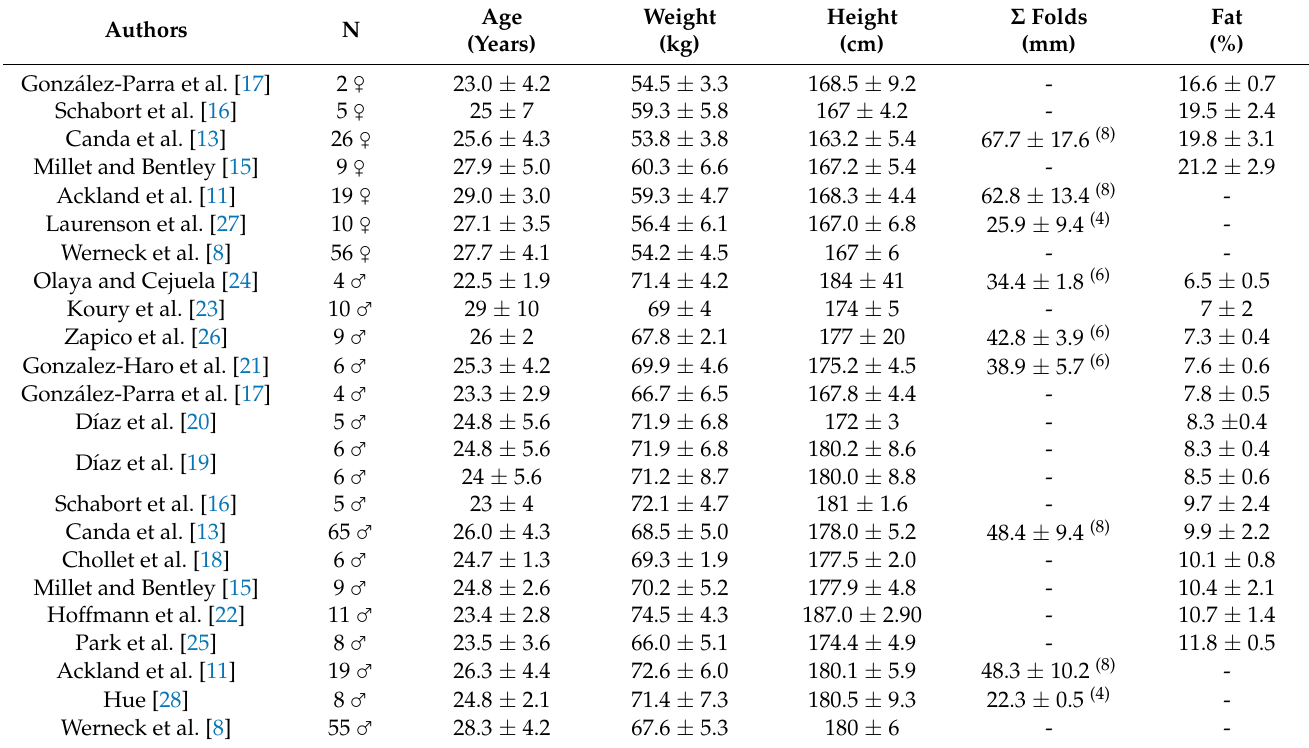
Table 2. Mean ± SD values for the anthropometric profile of elite